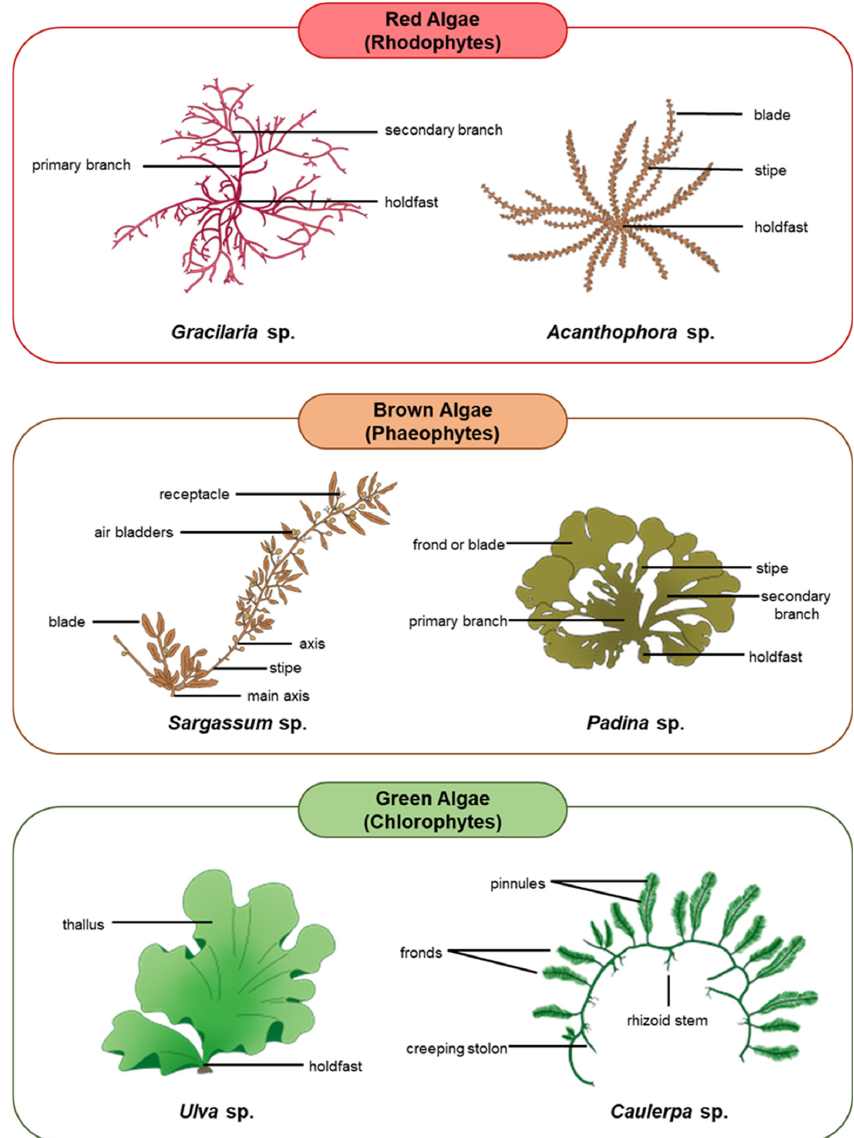
Figure 1. Major groups of macroalgae and examples of their common species. Table 1. Major groups of macroalgae and their